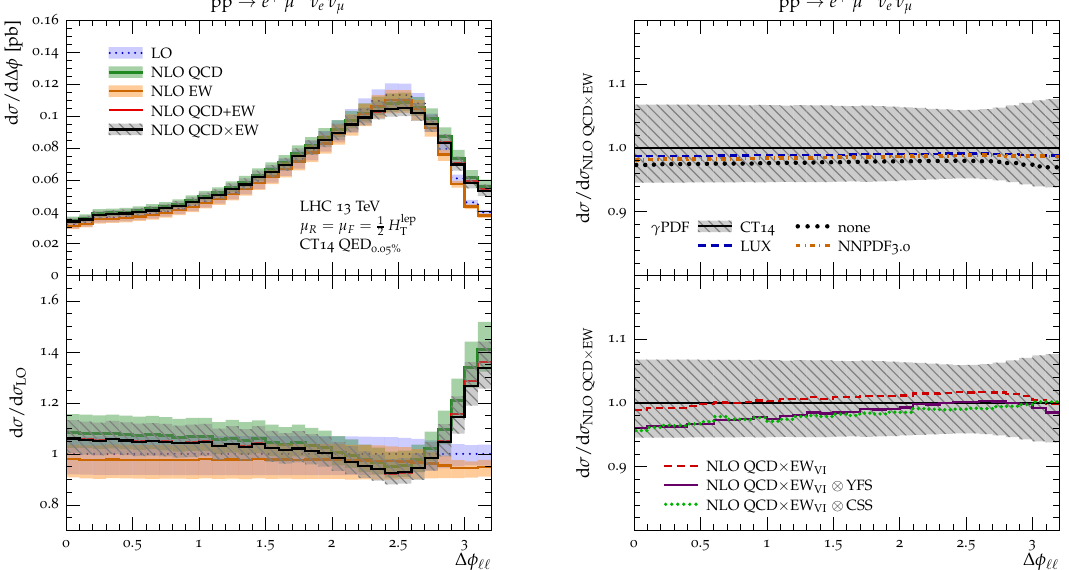
+ (cid:22) (cid:0) (cid:23) ‘‘ , for pp ! e e (cid:22) (cid:23) (cid:22)